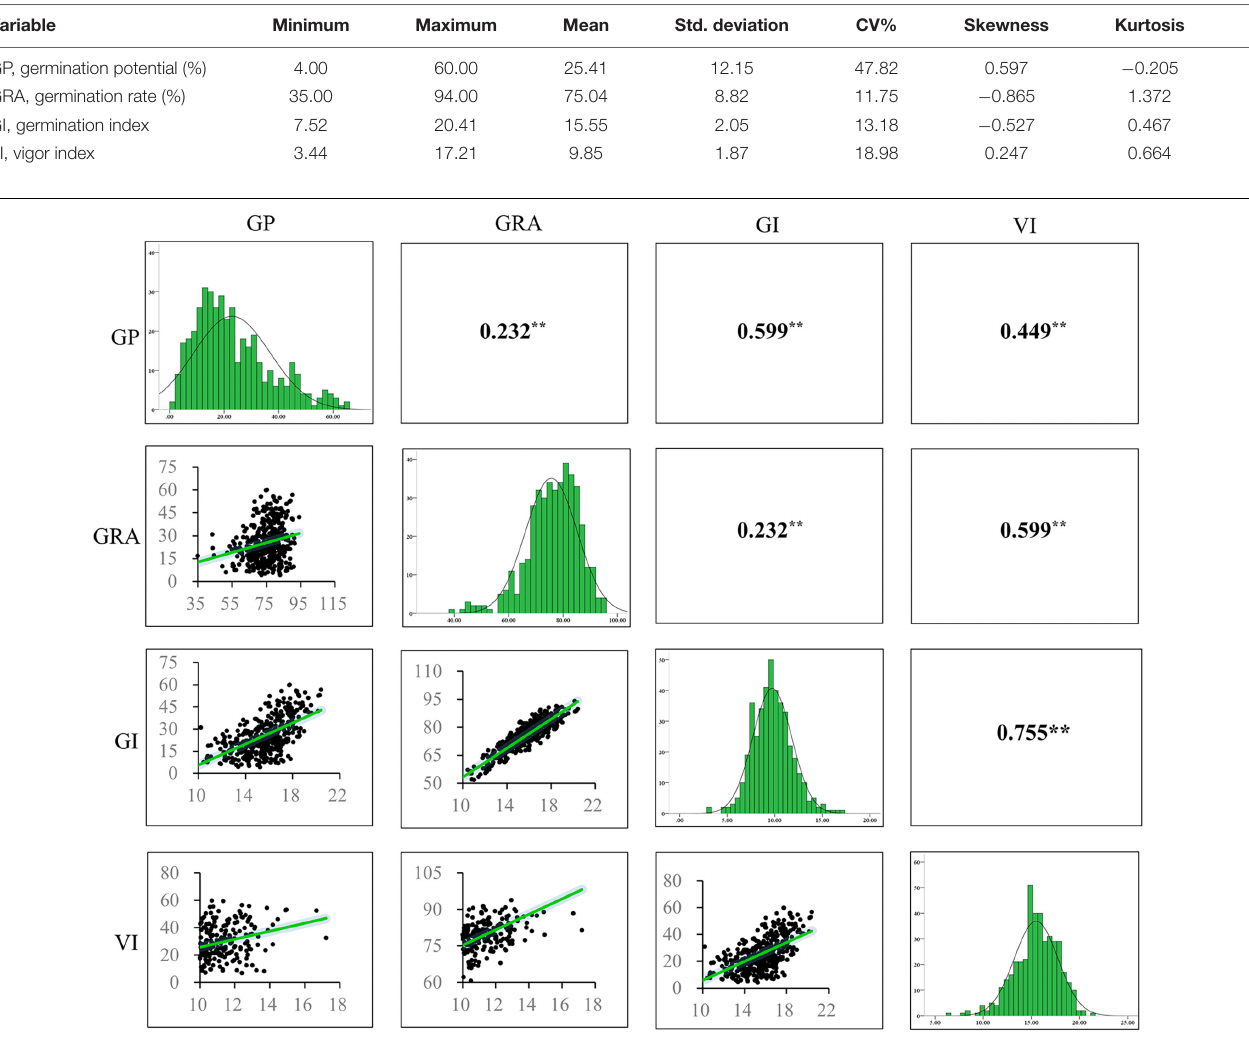
FIGURE 1 | Frequency distribution of phenotypic variation of four seed germination related traits and correlation coefficients among the traits in 419 accessions. ** indicates significance at the P < 0.01 level (two-tailed t -test). GP, germination potential; GRA, germination rate; GI, germination index; VI, vigor index.